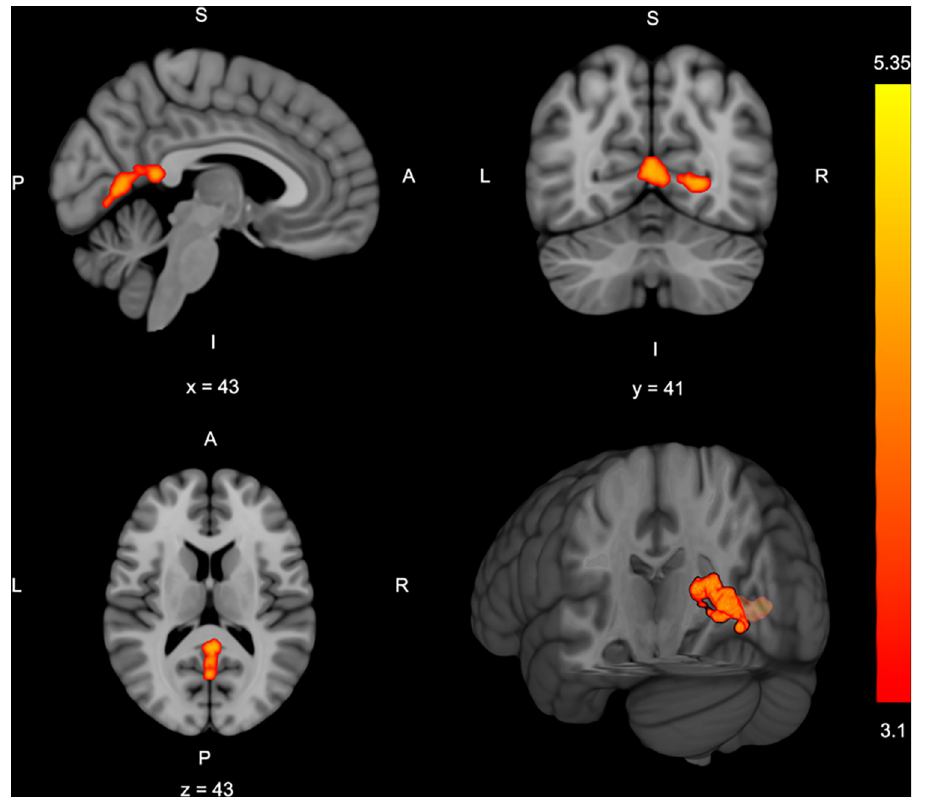
Fig 3. Group neural correlate z-statistic map (cluster threshold of z > 3.1, p < .05, corrected), depicting regions where greater brain activity was associated with greater knee abduction moment during drop landing. Slice location indicated by x, y or z location and S: Superior; L: Left; R: Right; I: Inferior; A: Anterior; P: Posterior for image orientation. The bar to right indicates the z-statistic color map.